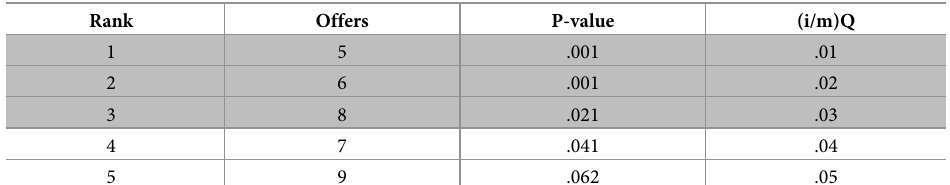
Table 2. Benjamini-Hochberg correction.